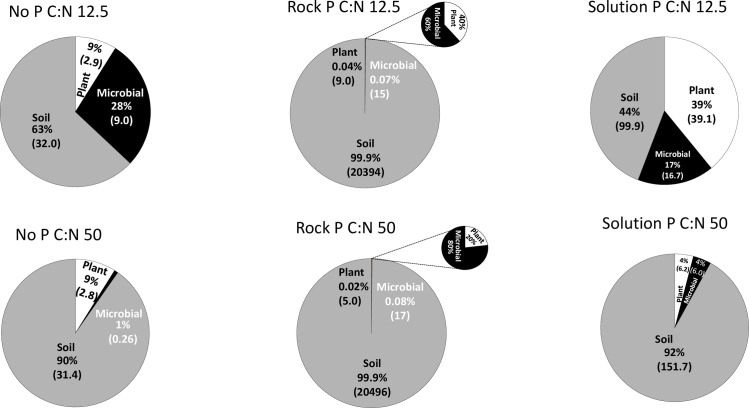
Apportionment of P in soil, accumulated plant biomass and microbial biomass pools quantified at the end of the 20-week pot trial and expressed as percentages and P content (mg P kg–1 soil) in parentheses.